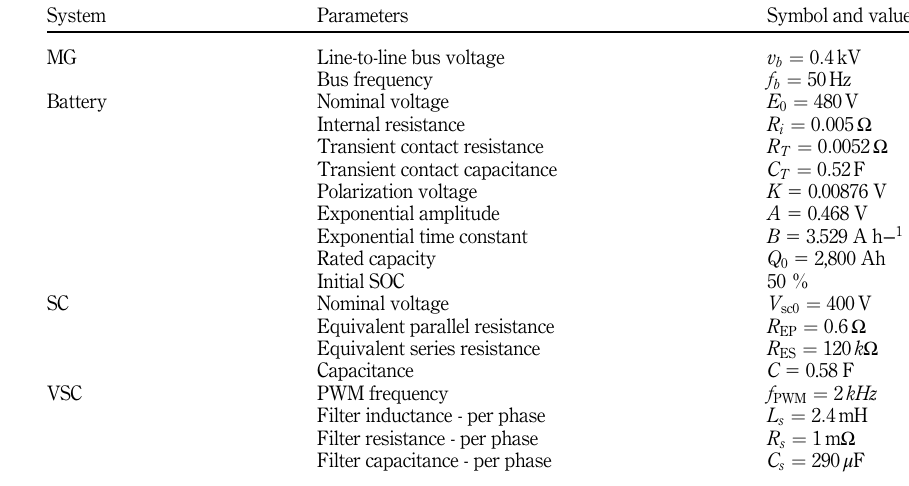
Table 1. Parameters of MG and